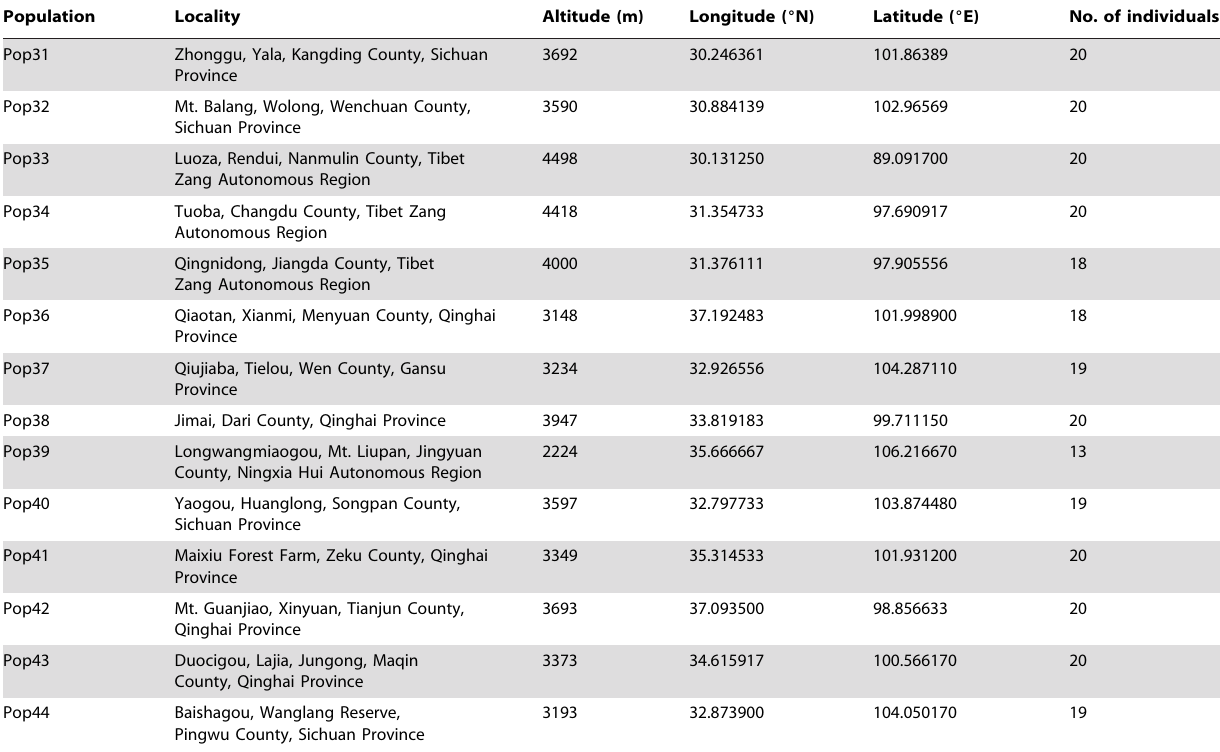
Population Locality